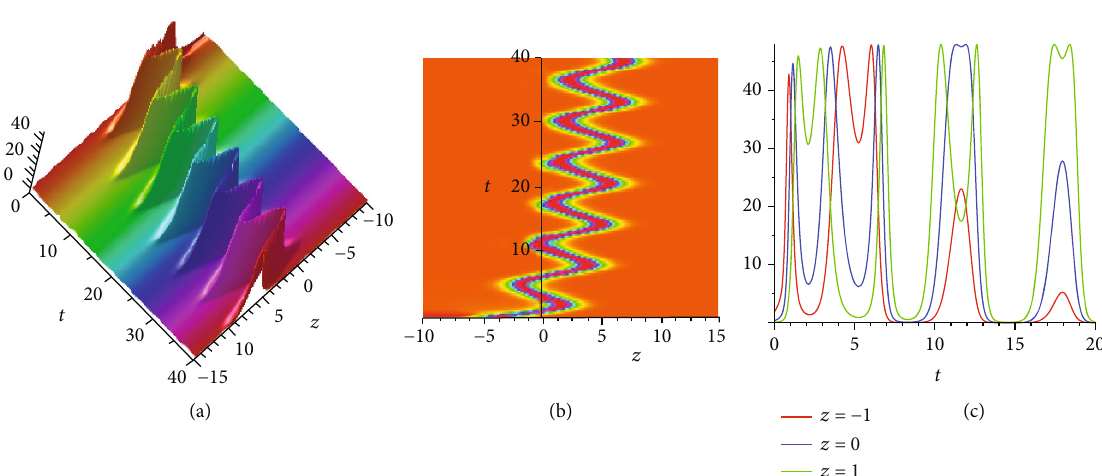
Figure 15: Plots of interaction with two lumps-soliton (61).